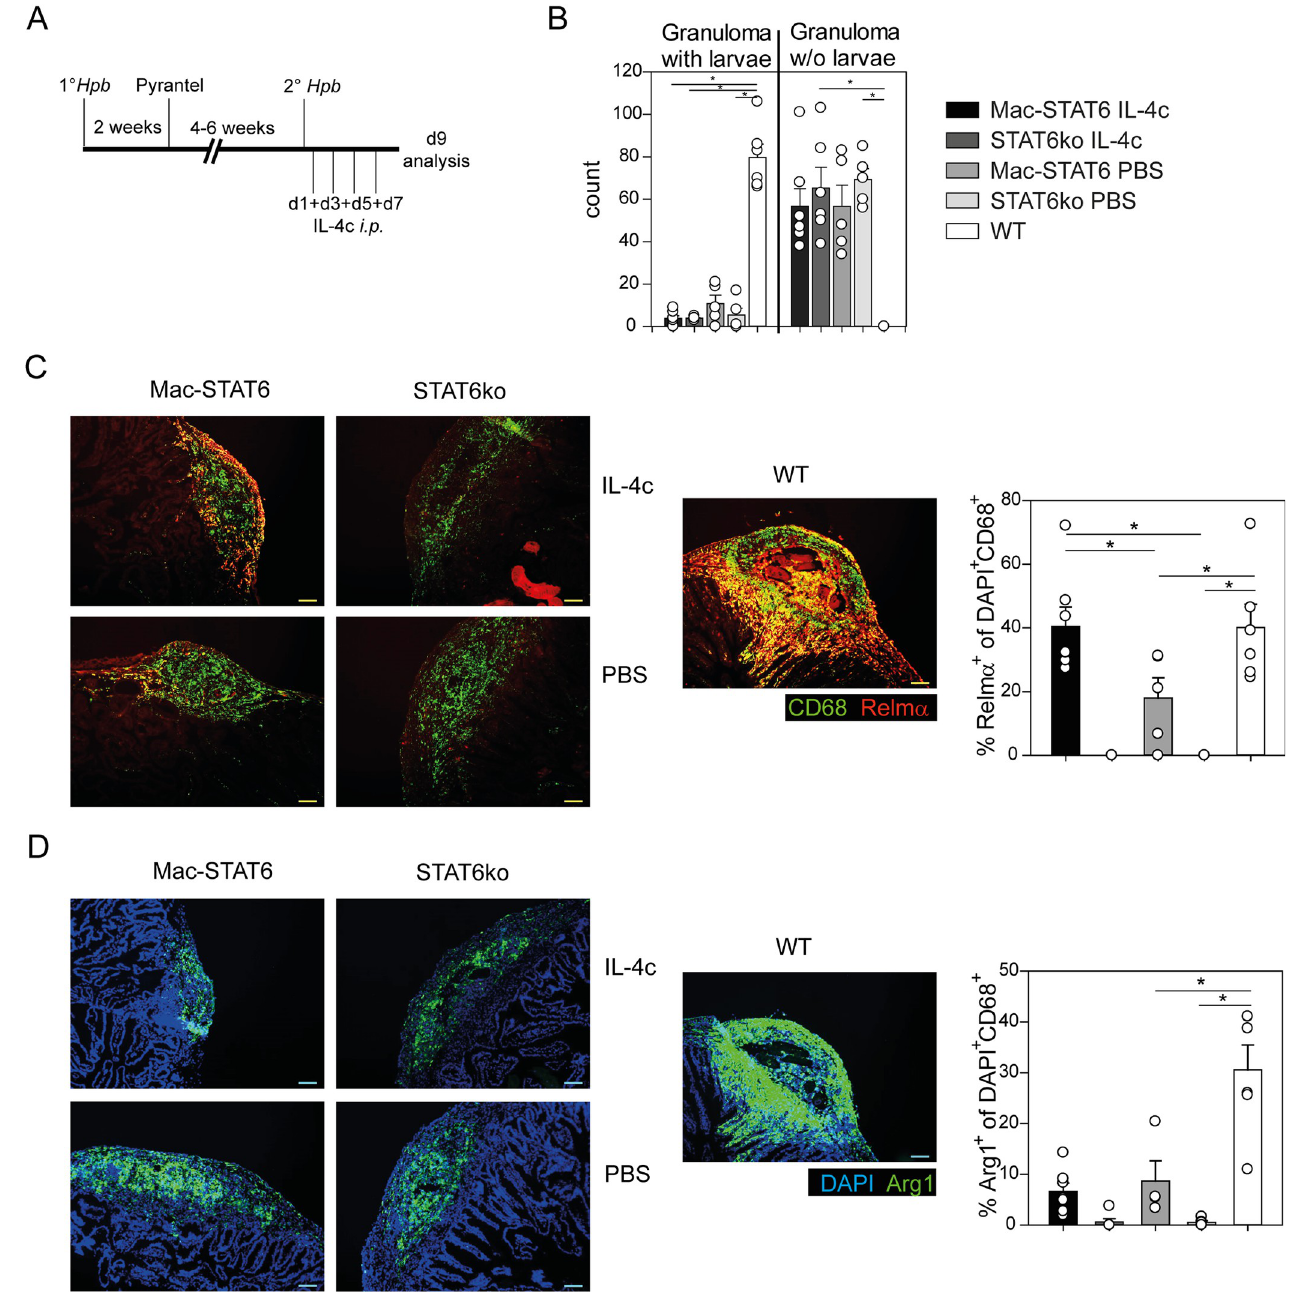
Fig 2. AAMs are not sufficient for larval trapping during a secondary Hpb infection. A) Schematic timeline: Mac-STAT6 mice, STAT6ko mice or BALB/c (WT) control mice were primary infected with Hpb , infection was cleared by Pyrantel pamoate after two weeks and four to six weeks later, mice were secondarily infected. 5 μ g/mouse IL-4c in 100 μ l PBS or PBS for control groups was injected i . p . on days 1, 3, 5 and 7 after secondary infection. B) Mean + SEM of granuloma with or without (w/o) larvae on day 9 after secondary infection. Statistical analysis was performed separately for granuloma with or w/o larvae by Kruskal-Wallis with Dunn’s post-hoc testing. * p < 0.05. Data are pooled from three independent experiments with five to seven mice per group. C and D) Histological stainings and quantifications of small intestinal cross-sections day 9 after secondary Hpb infection for detection of Relm- α (red) and CD68 (green) (C), or DAPI (blue) and Arg1 (green) (D). Quantification plots display Mean + SEM of percentage of Relm- α + or Arg1 + of DAPI + CD68 + macrophages, respectively. Representative picture and quantification for four to seven mice per genotype. Scale bar is 100 μ m.